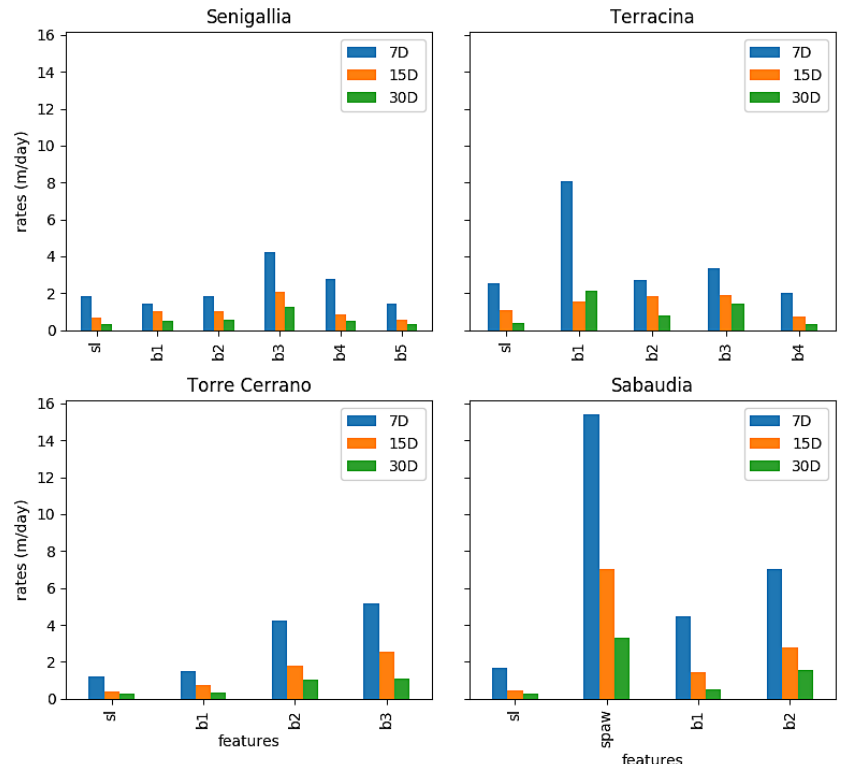
Figure 7. Maximum rates of variability for sampled morphology features at the investigated sites. The rates are computed with different temporal windows: 7 days (blue bars), 15 days (orange bars), and 1 month (green